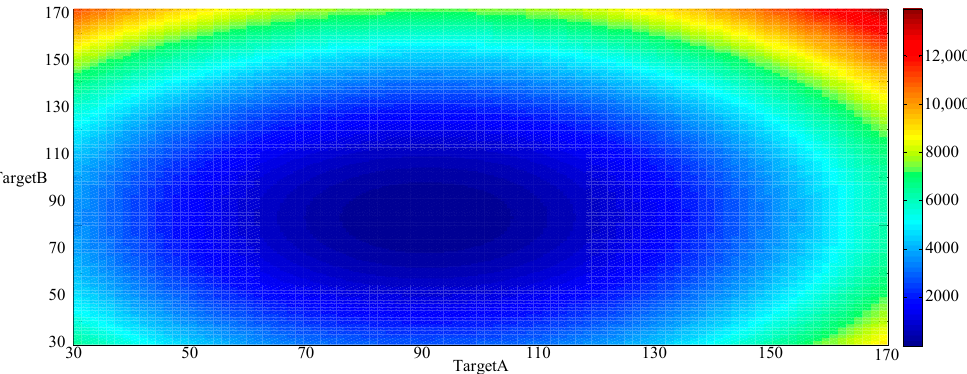
Figure 15. Solution space in contour way.